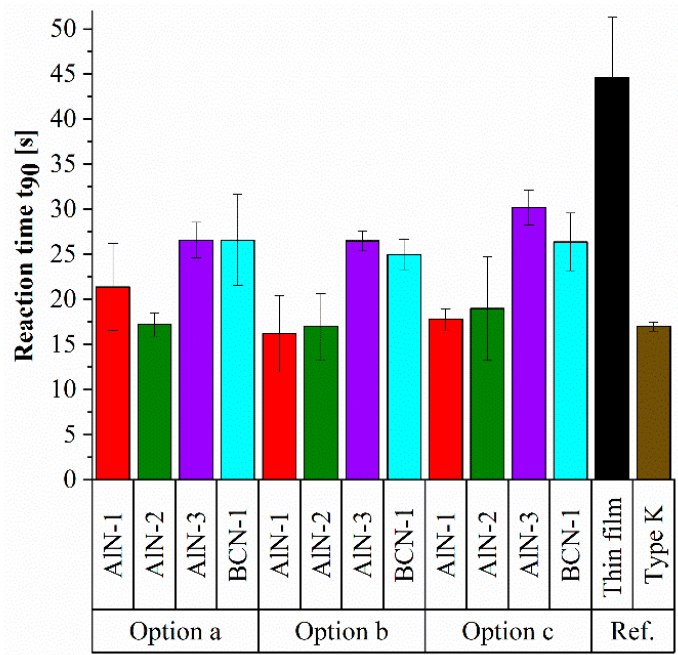
Figure 12. Reaction time of the coated thin film thermocouples and the industrial type K reference.